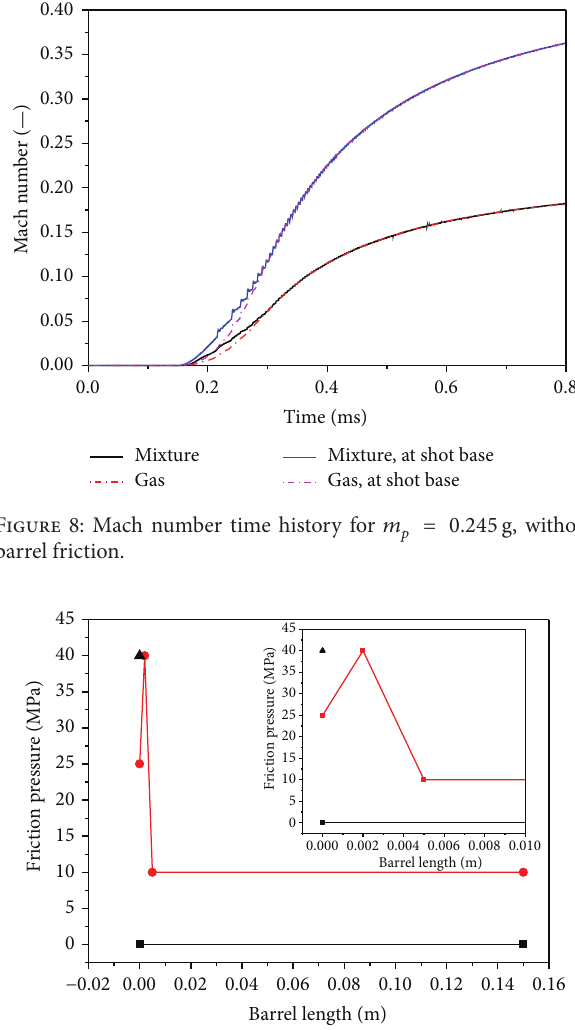
Figure 6: Shot pressure and shot velocity against shot travel for = 0.245 g, without barrel friction. 𝑚 𝑝